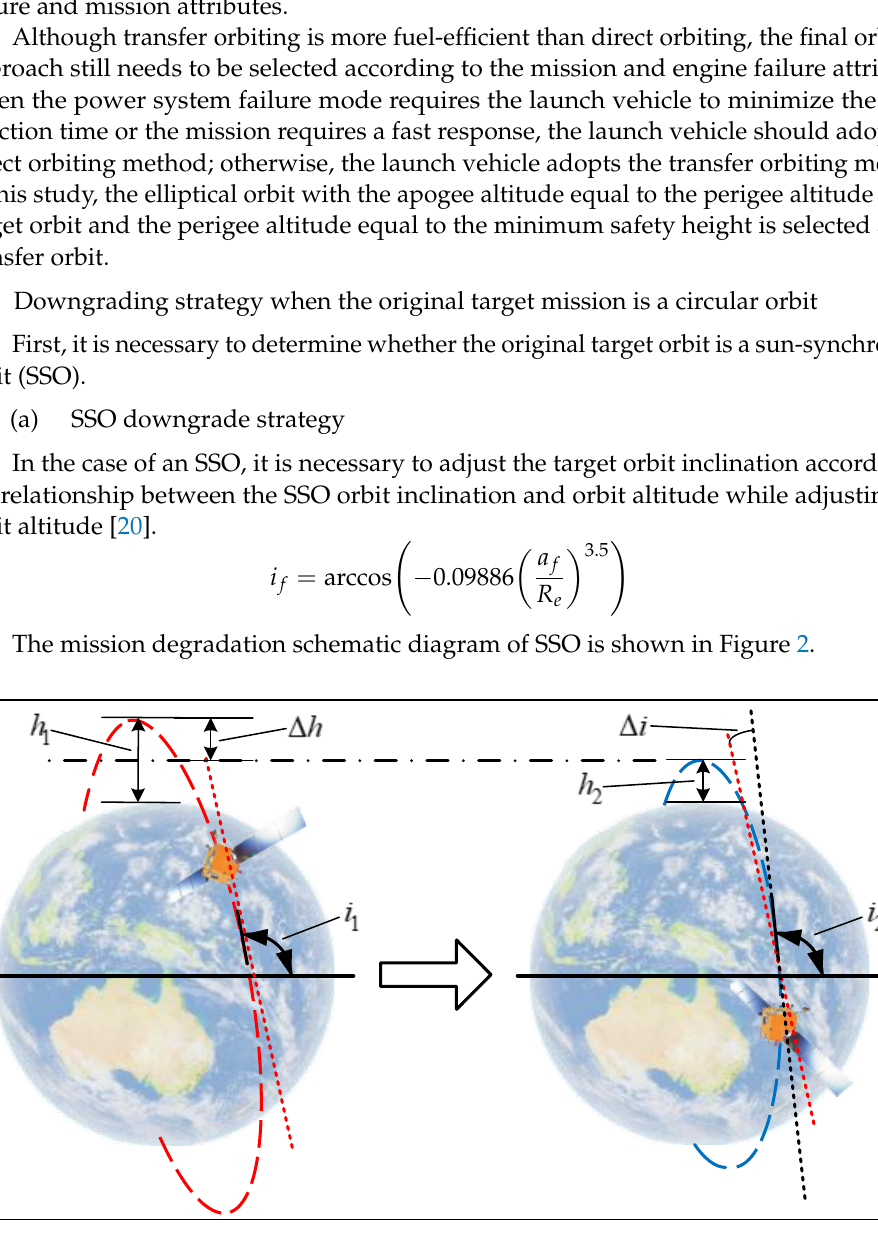
Figure 2. Schematic diagram of sun-synchronous orbit degradation.